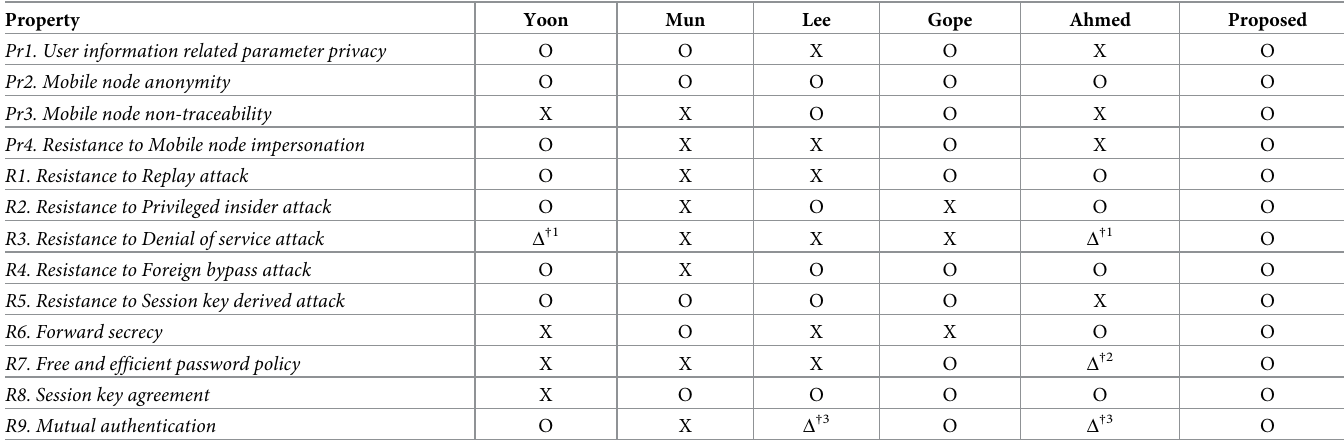
Table 2. Security comparison of the proposed scheme and other related